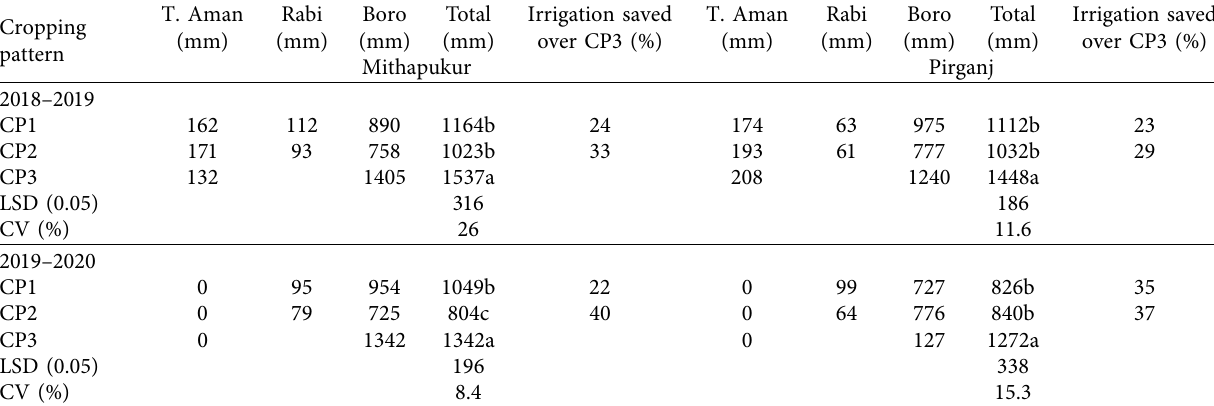
Table 2: Irrigation applied (mm) in different cropping patterns (CP1: T. Aman-Mustard-Boro, CP2: T. Aman-Potato-Boro, CP3: T. Aman- Fallow-Boro) at Mithapukur and Pirganj, Rangpur during 2018–2019 and 2019–2020. Cropping